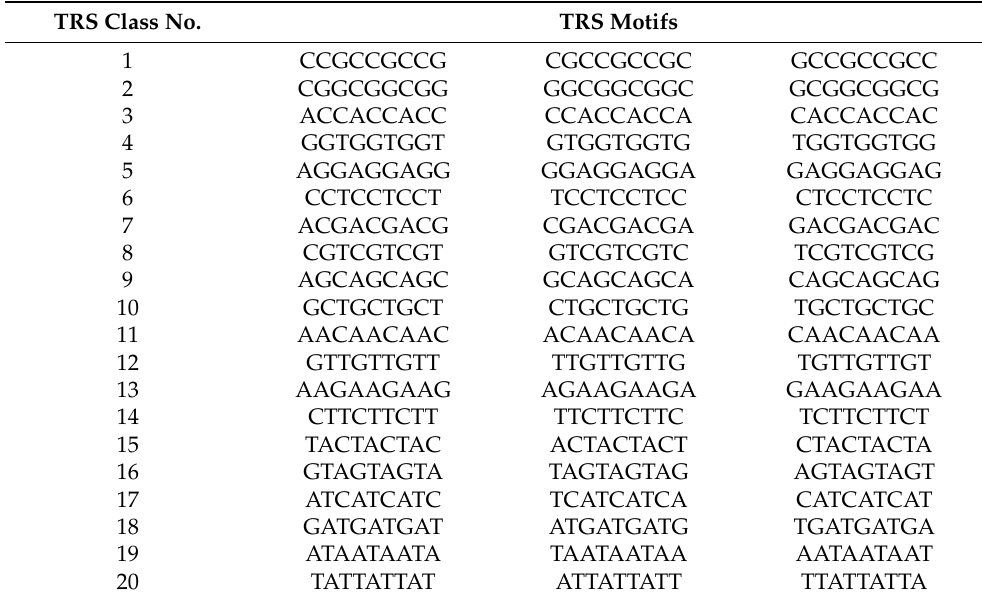
Table 1. All trinucleotide motifs, excluding mononucleotide repetitions, are grouped in 20 classes. Each class consists of three possible frames of the same